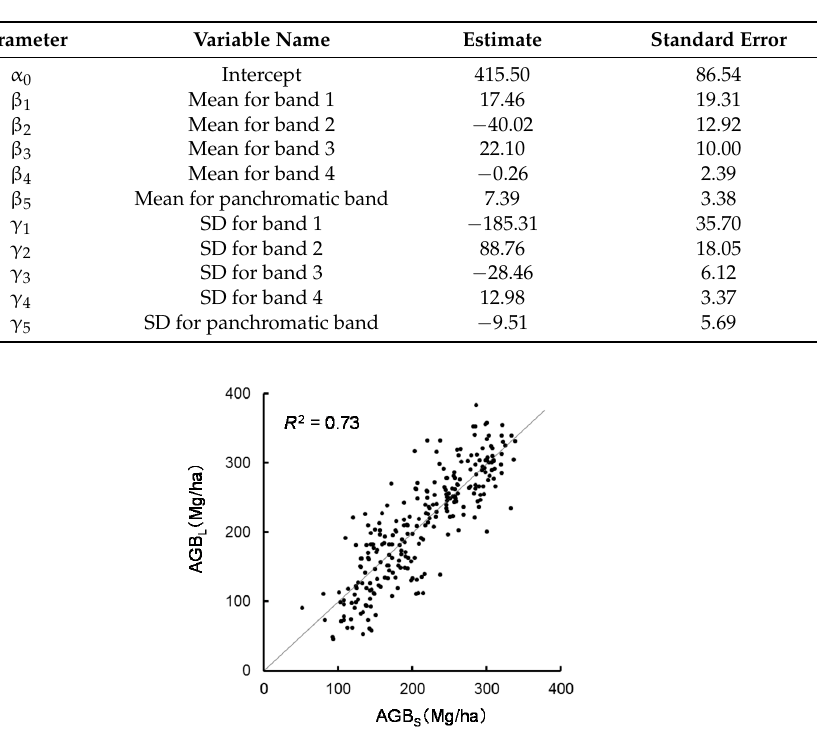
Figure 6. The relationship between the AGB predicted from the LiDAR-based model (AGB L ) and the AGB predicted from the model based on the satellite image data (AGB S ) for each object.